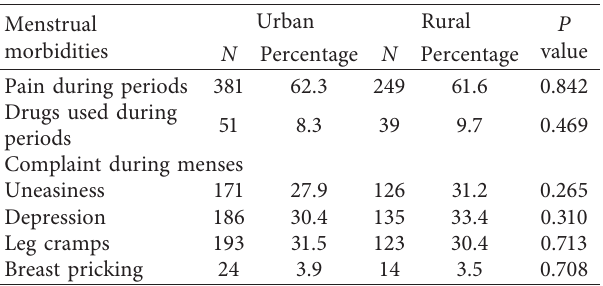
Table 2: Menstrual morbidities experienced by the participants by the place of